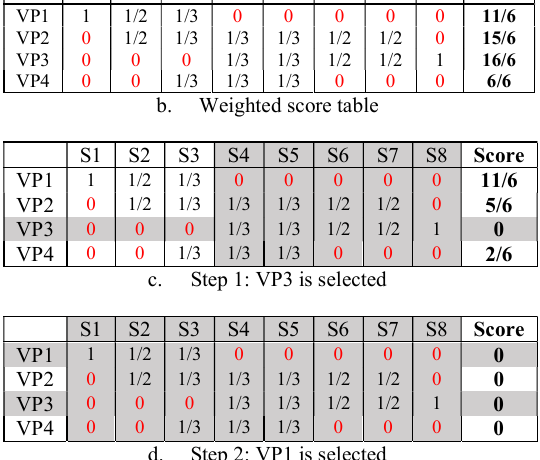
Table 2. Example 1: Weighted Greedy